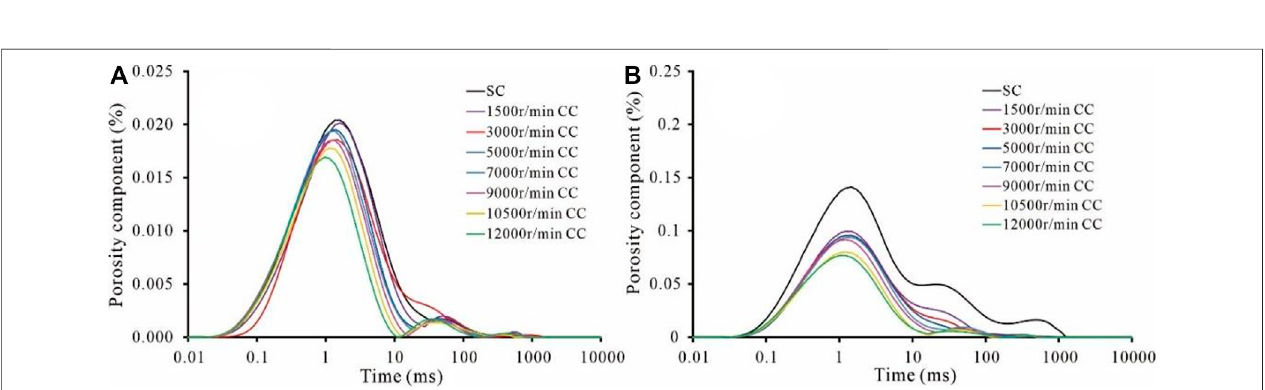
FIGURE 6 | T2 spectrum of NMR Sample #21. Note: (A) Sample #21 only with matrix and (B) Sample #21 after cracking; “ SC ” , saturation component; “ CC ” , centrifugal component.